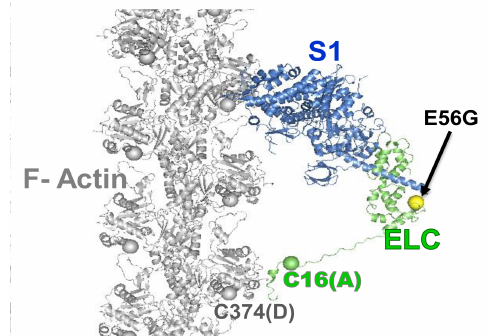
Figure 3. Model of actin-myosin complex with skeletal myosin S1 strongly bound to actin. Spheres show the donor (D) and acceptor (A) labeling sites on actin (C374, grey), on myosin (C16, green), and the HCM mutation (E56G, yellow). The C374(actin)-C16(ELC) FRET sensor was designed to determine the effect of the E56G HCM mutation in hVELC on actomyosin function. Adapted from [27], Guhathakurta, P.; Prochniewicz, E.; Roopnarine, O.; Rohde, J.A.; Thomas, D.D. A Cardiomyopathy Mutation in the Myosin Essential Light Chain Alters Actomyosin Structure. Biophys . J . 2017 , 113